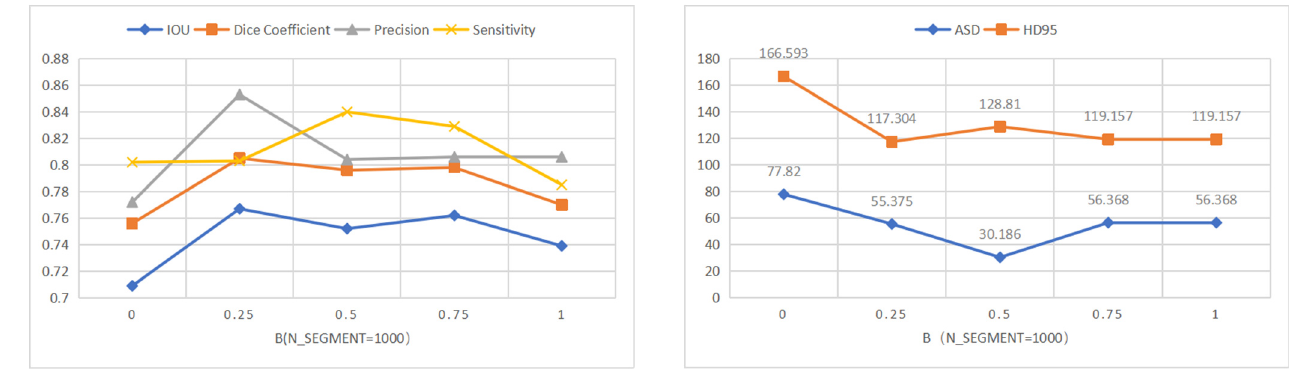
Figure 7. Performances of our method with different values of β on ISIC 2018 dataset.